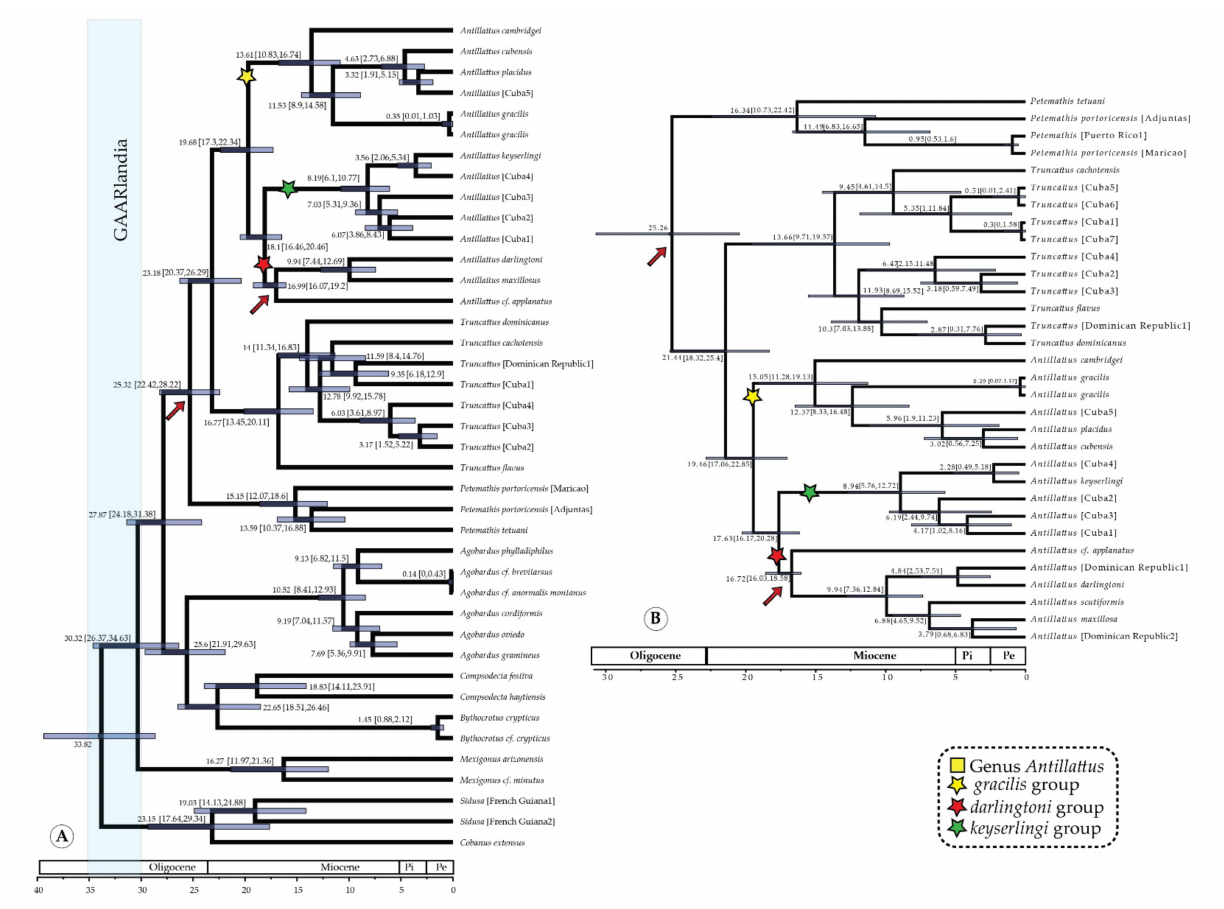
Figure 5. Beast divergence time estimations of all genes (CO1, 16S-ND1, 28S) using a Bayesian relaxed molecular clock ( A ) with outgroups and ( B ) without outgroups. The scale is in millions of years. Bars show 95% HPD [highest posterior density]. Stars indicate species groups within the genus Antillattus (blue star gracilis group, red star darlingtonia group, and green star keyserlingi group). Arrows indicate calibrated